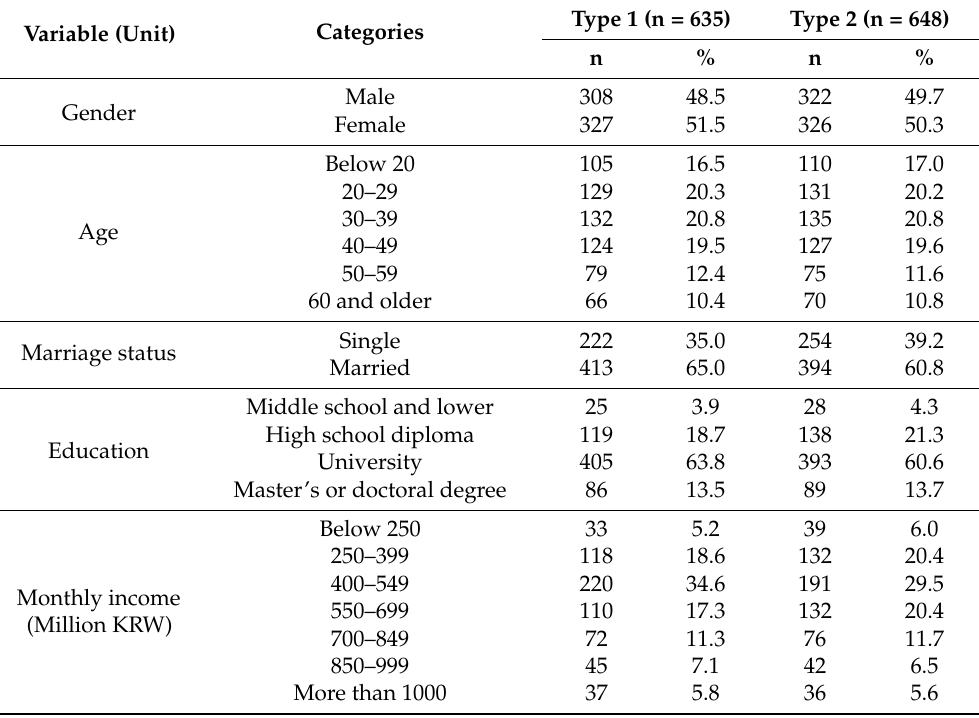
Table 2. Sociodemographic profile of respondents (N =